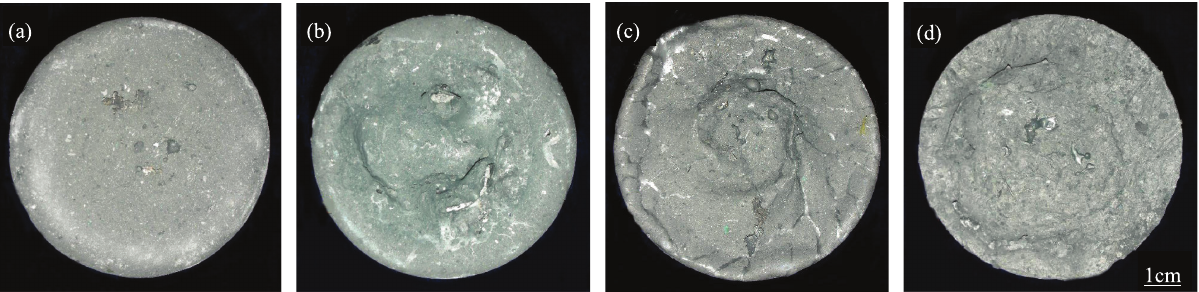
Fig. 2: Surface topography of IN100 superalloy castings in (a) I DC = 0A, I AC = 0A; (b) I DC = 0A, I AC = 60A; (c) I DC = 150A, I AC = 60A; (d) I DC = 290A, I AC =